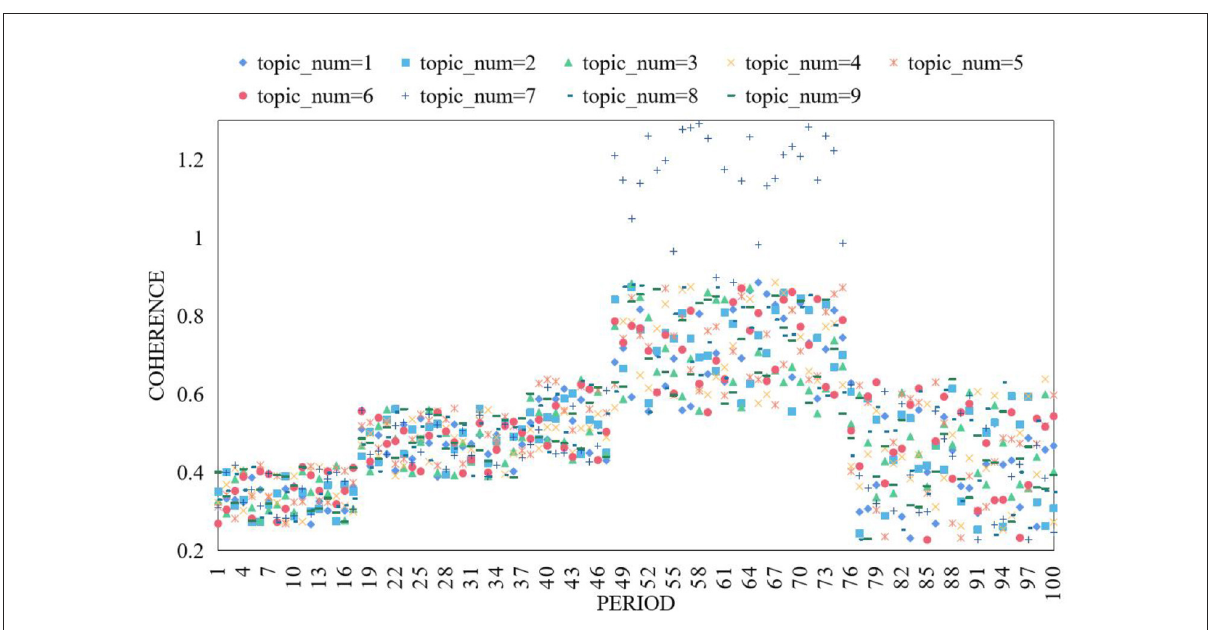
FIGURE5 Consistency comparison of the number of different